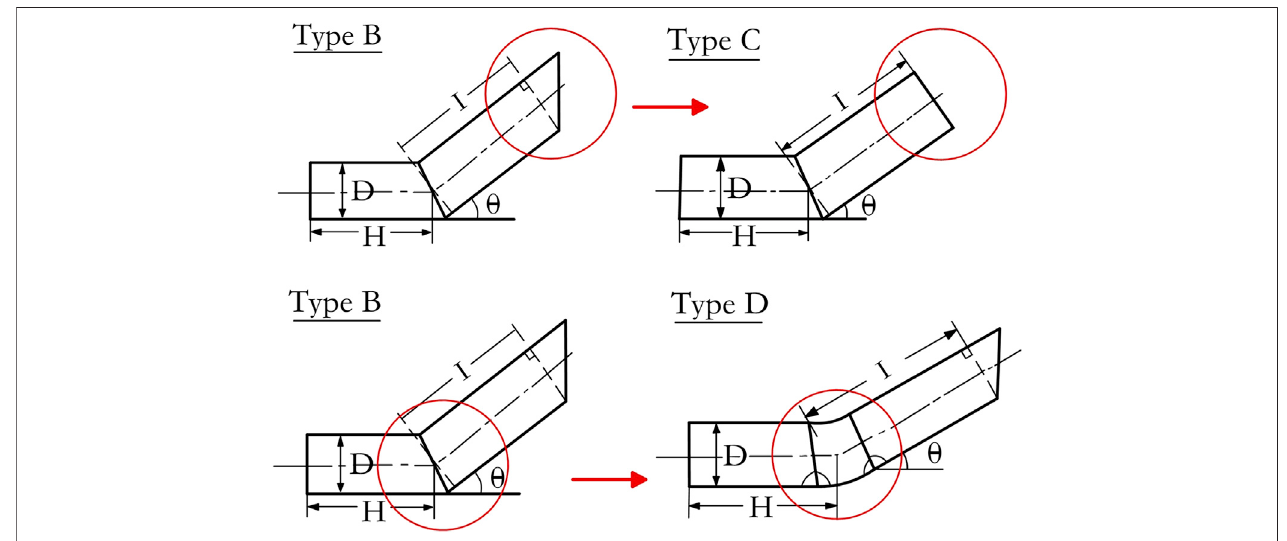
FIGURE 4 | Schematic diagram of experimental Types C and D.